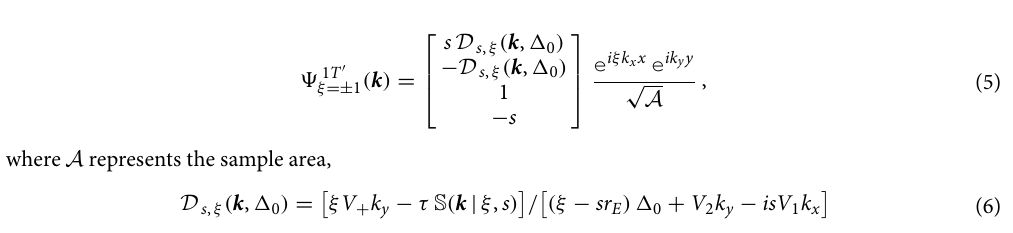
Figure 3. (Color online) Contour plots ( a )-( b ) with r E 0, k , s ) 2 E ( 0 ) for non-irradiated 1T ε τ 1 ( k x y | ξ = = =± corresponds to a different value of the perpendicular electric field r E 1 for these four plots, ξ =